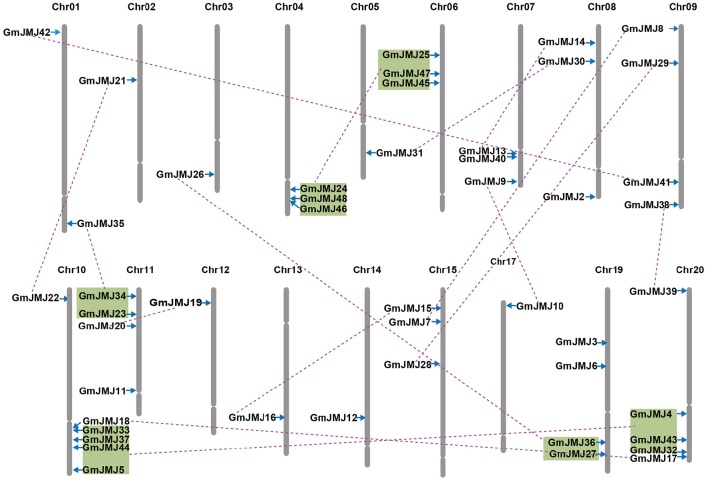
Chromosomal locations, region duplication, and predicted cluster for soybean JmjC genes. The chromosome number is indicated above each chromosome. Throat on the chromosomes indicate the position of centromere. Only those chromosomes bearing JmjC genes (18) were represented. Segmental duplicated genes are indicated by purple lines. Colored boxes indicate the gene blocks generated by the most recently WGD event. The figure was produced and modified using the MapChart and Adobe Illustrator, respectively.